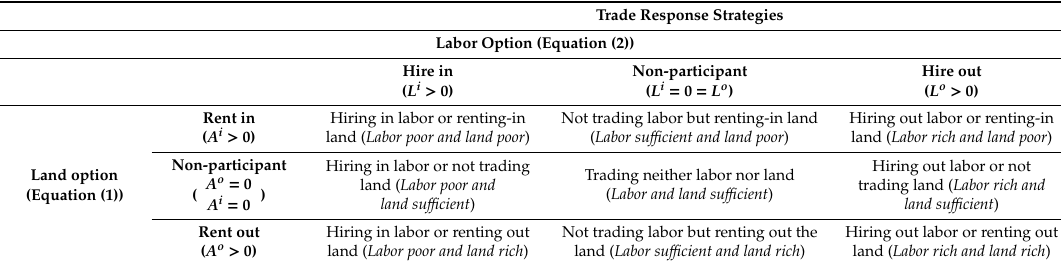
Table 1. Summary of potential optimal household trade response